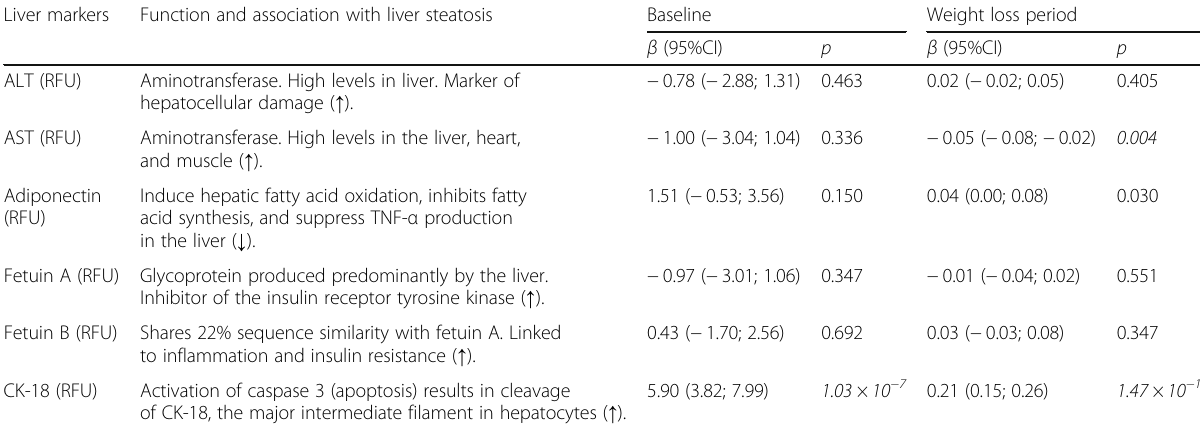
Table 3 Plasma ANGPTL3 and association with liver markers Liver markers Function and association with liver steatosis Baseline